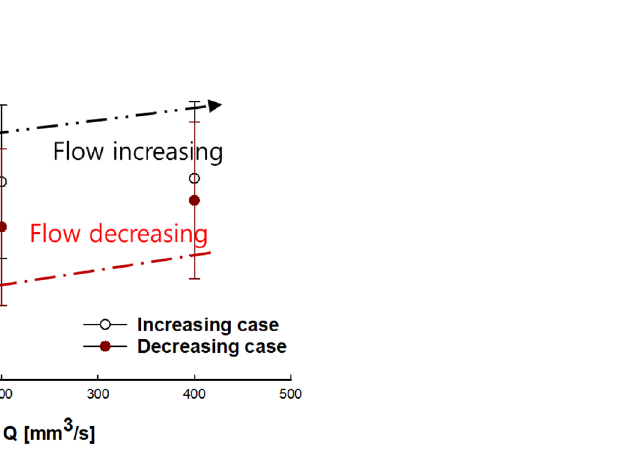
Figure 4. Schematic of tow compression and flow passage change.